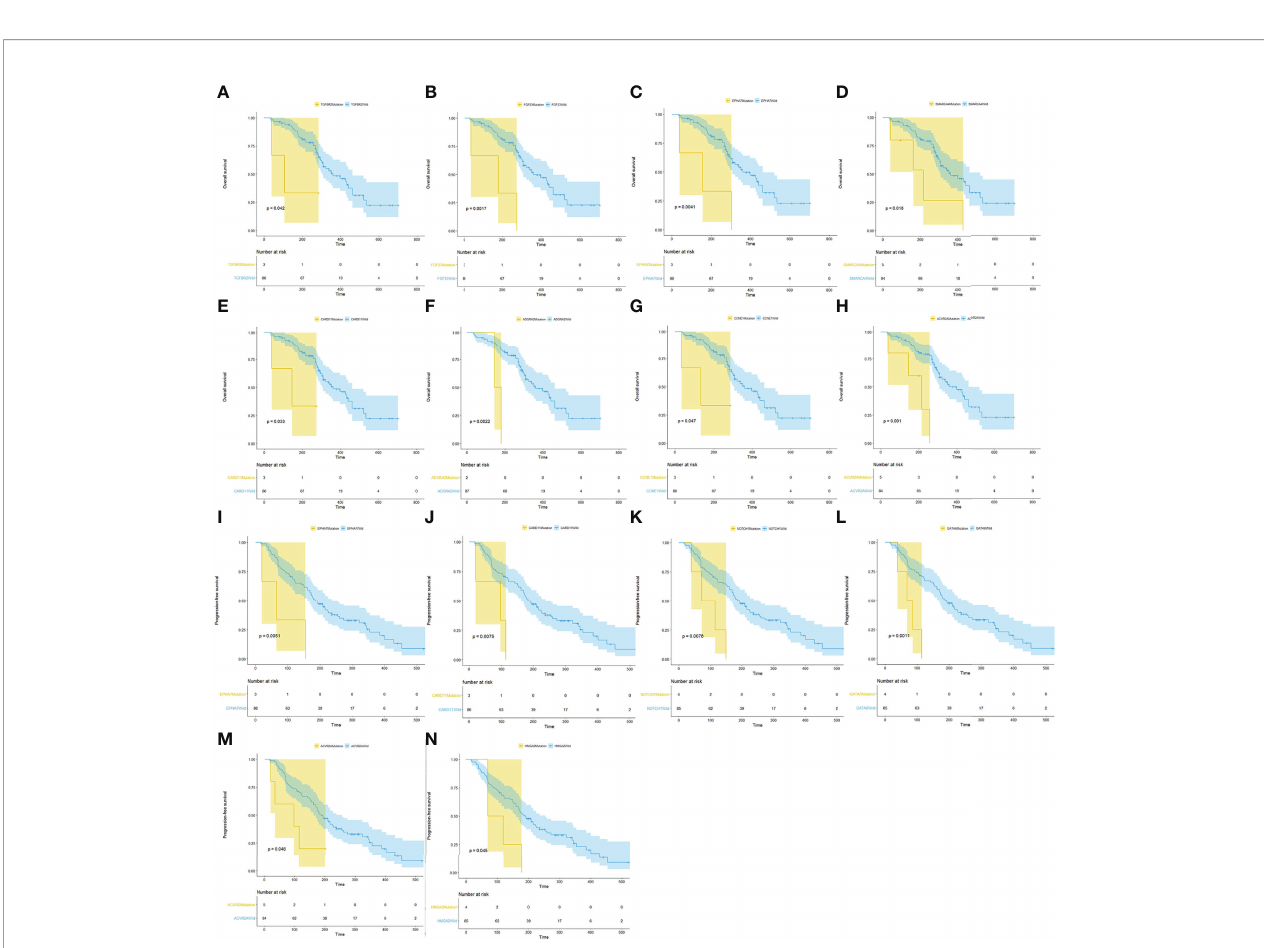
FIGURE 5 | Analysis of mutated genes associated with prognosis. (A – H) Survival analysis showed that patients with TGFR2B, FGF23, EPHA7, SMARCA4, CARD11, ADGRA2, CCNE1 , and ACVR2A alterations had a worse OS. (I – N) EPHA7, CARD11, NOTCH1, GATA6, ACVR2A , and HMGA2 S mutations indicated undesirable PFS.